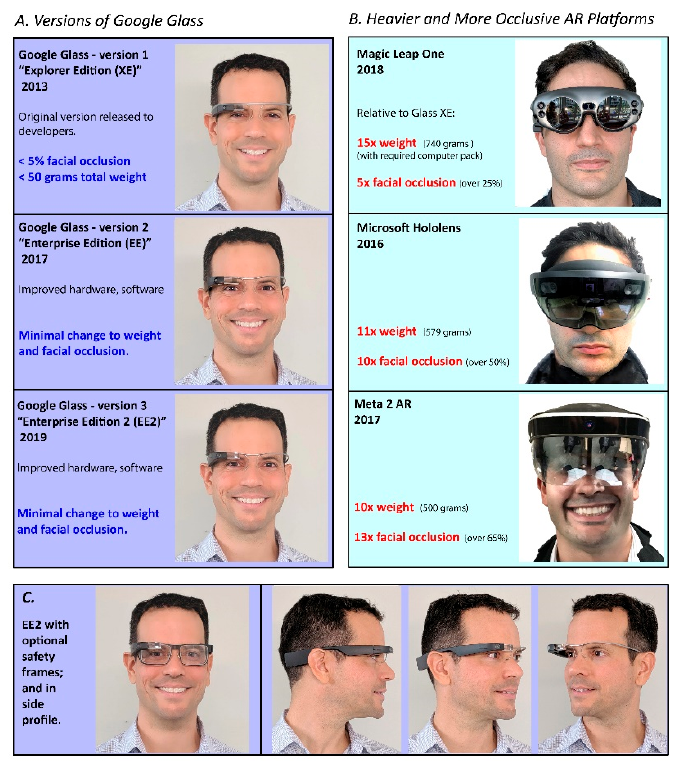
Figure 1. ( A ) Google Glass versions 1–3 (Explorer Edition, Enterprise Edition, Enterprise Edition